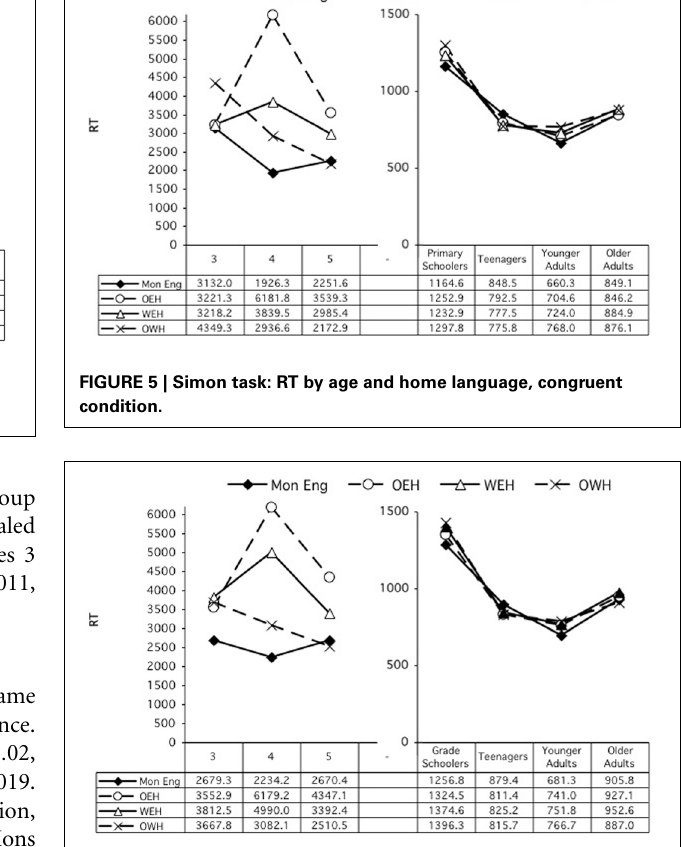
FIGURE 6 | Simon task: RT by age and home language, incongruent